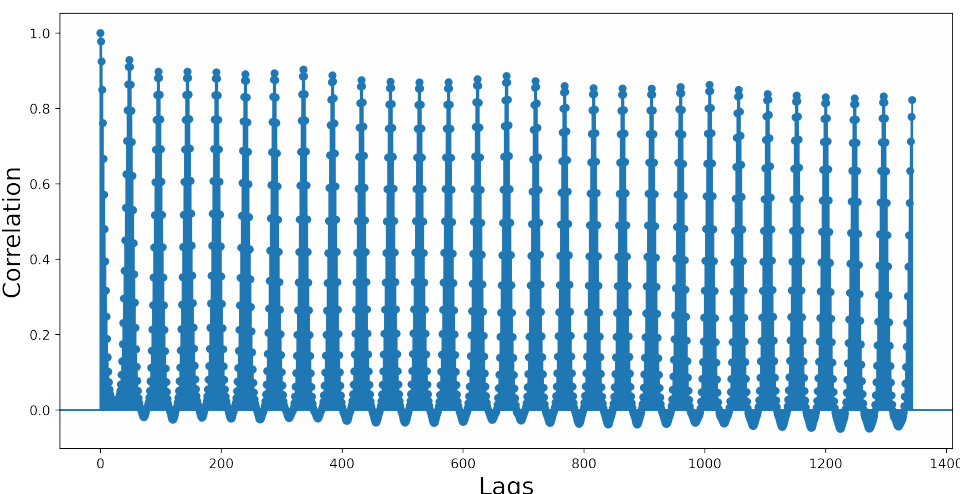
Figure 4. The autocorrelation of the demand presents daily peaks, which steadily decrease as the lag increases (here, a lag unit represents a 30 min period). The plot displays the autocorrelation for a maximum lag of four